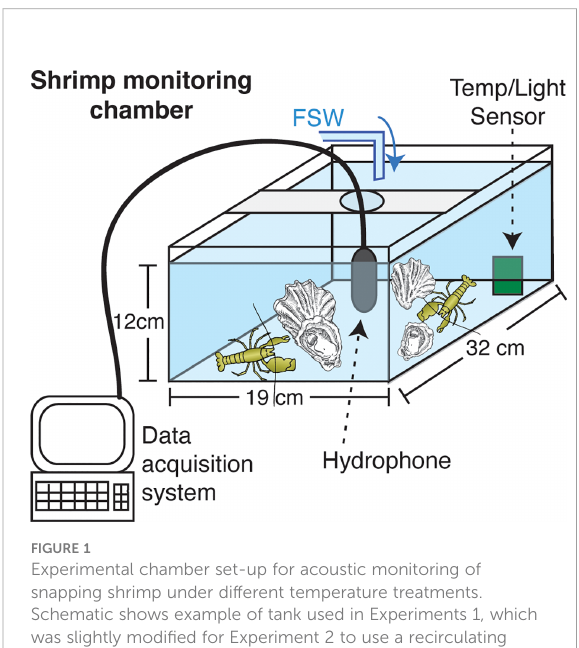
FIGURE 1 Experimental chamber set-up for acoustic monitoring of snapping shrimp under different temperature treatments. Schematic shows example of tank used in Experiments 1, which was slightly modi fi ed for Experiment 2 to use a recirculating water bath rather than fl ow-through to achieve desired temperatures. Experiment 3 was conducted with the same data acquisition and overall set-up but in larger seawater tables to accommodate 10 shrimp and sheltering habitat. Sample sizes, treatments, and groupings for each experiment appear